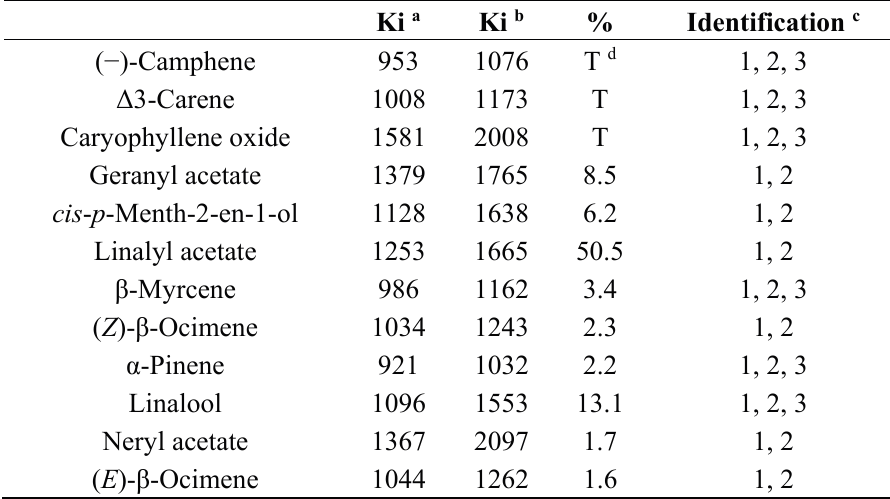
Table 1. Composition of the essential oil from leaves of Skimmia